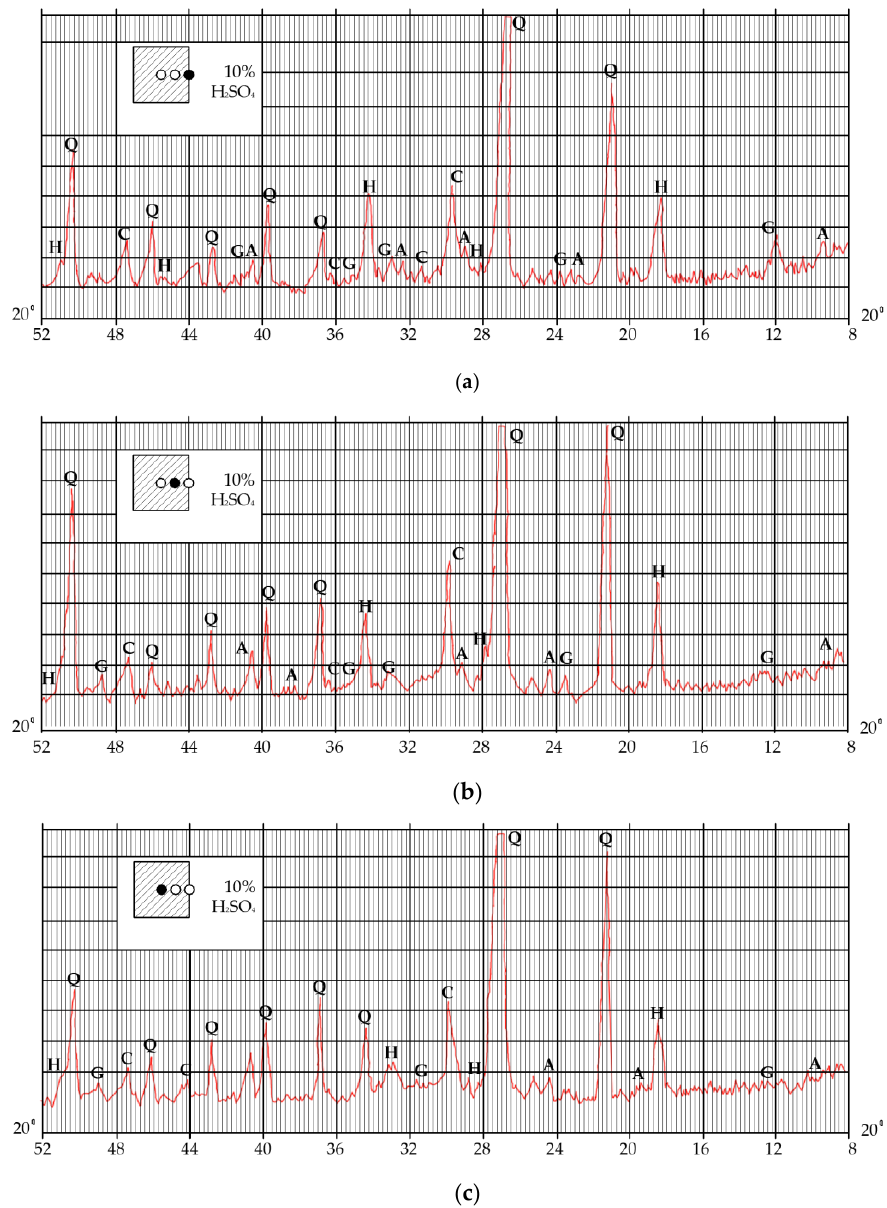
Figure 17. Diffractogram of X-ray phase analysis of concrete after the action of the H 2 SO 4 solution: ( a ) near the surface, ( b ) at a distance of 4 – 6 mm from the surface and ( c ) at a distance of 10 mm from the surface (Q — quartz (SiO 2 ), C — calcid (CaCO 3 ), H — calcium hydroxide (Ca(OH) 2 ), G — gypsum (CaSO 4 • 2H 2 O), A — calcium aluminohydrochloride (3CaO • Al 2 O 3 • 3CaSO 4 • 32H 2 O)).